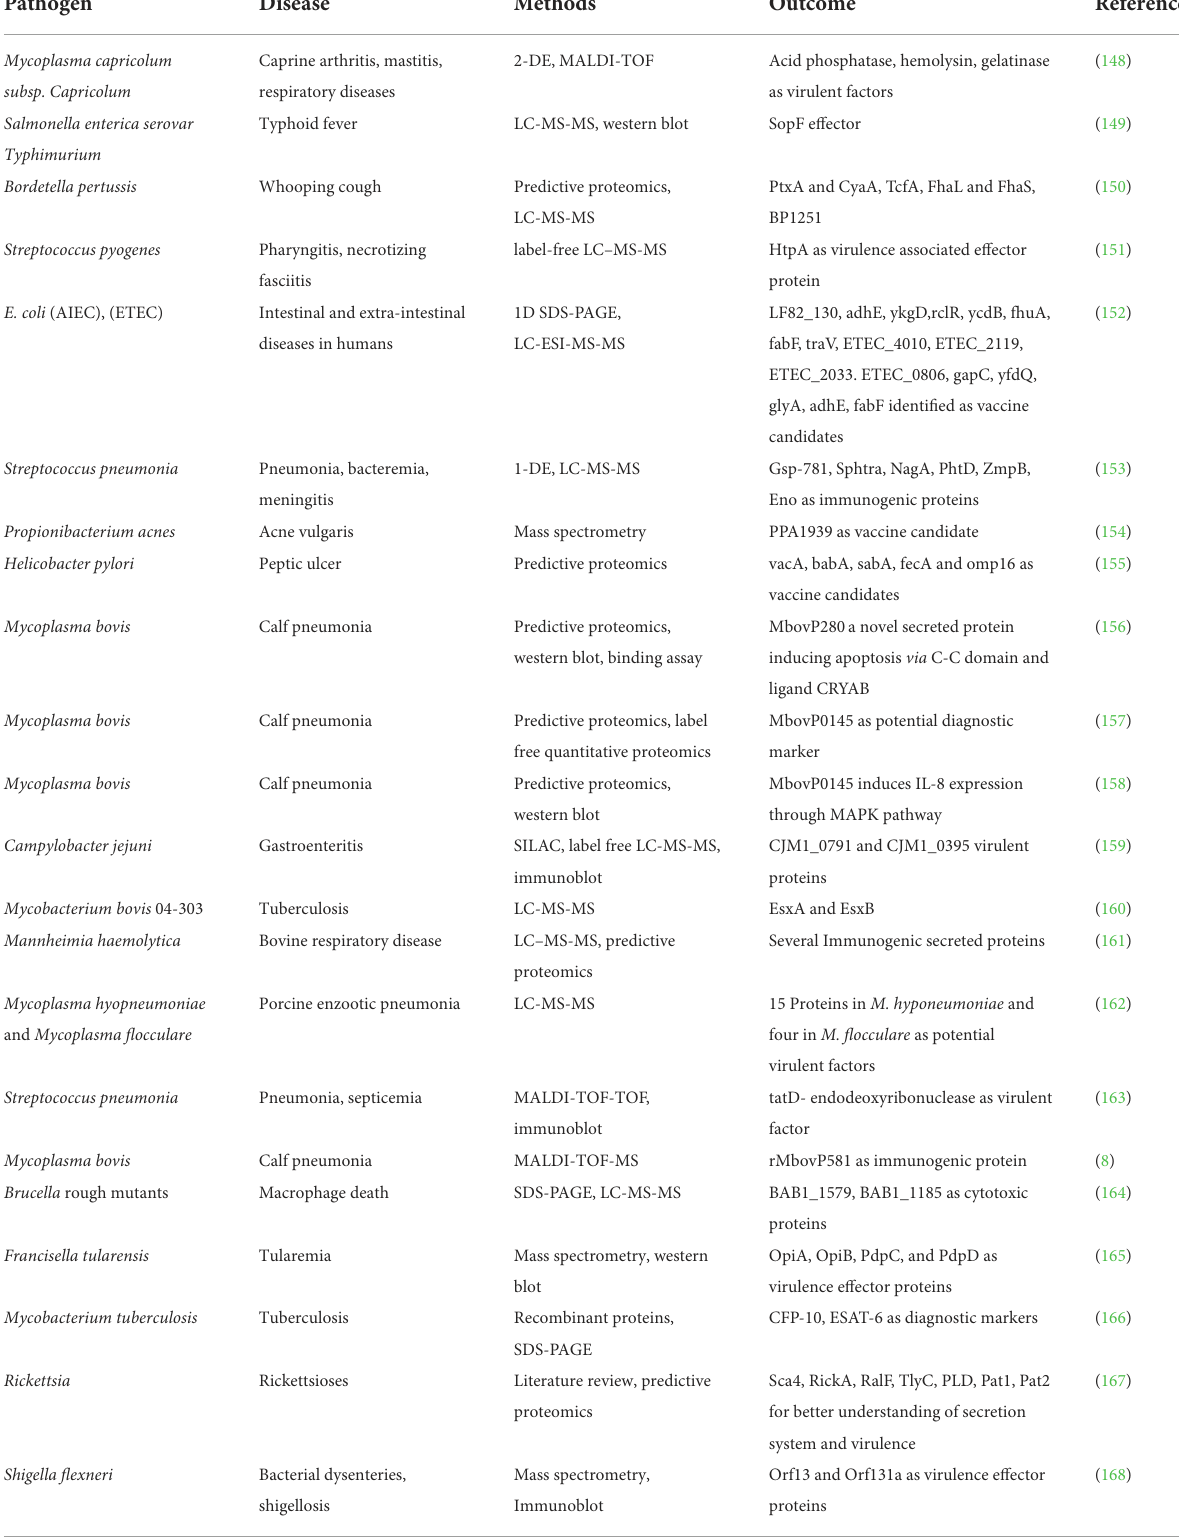
TABLE 2 Secreted proteins from important bacterial pathogens using proteomics